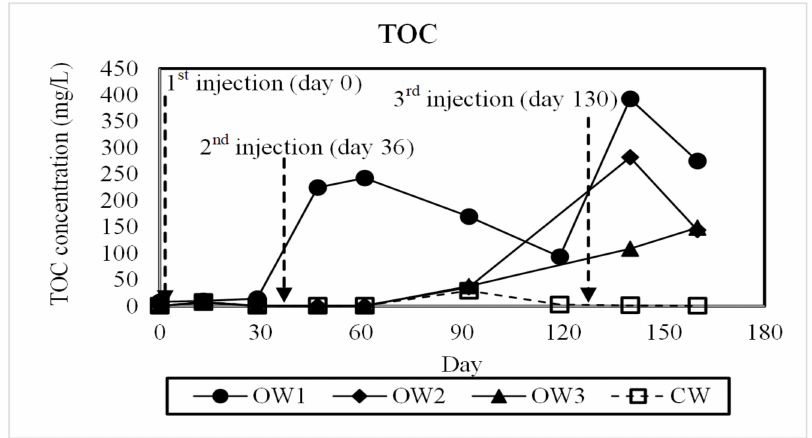
Figure 6. TOC concentration variations before and after injection for each monitoring well in the in situ field